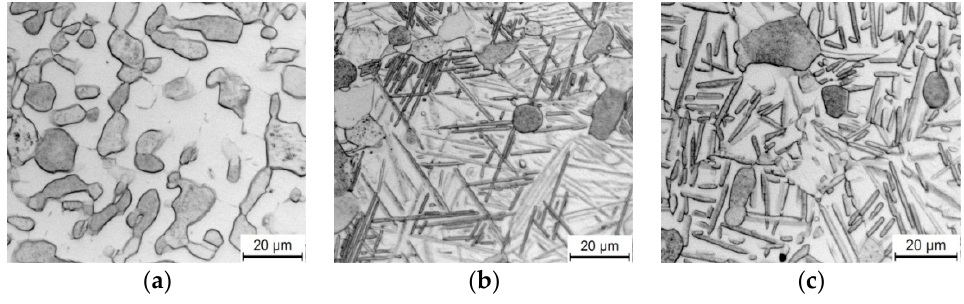
Figure 10. Optical microscopy micrographs of specimens after heated up to 940 °C at 5 °C/min: ( a ) equiaxed structure; ( b ) bimodal structure; ( c ) trimodal structure.